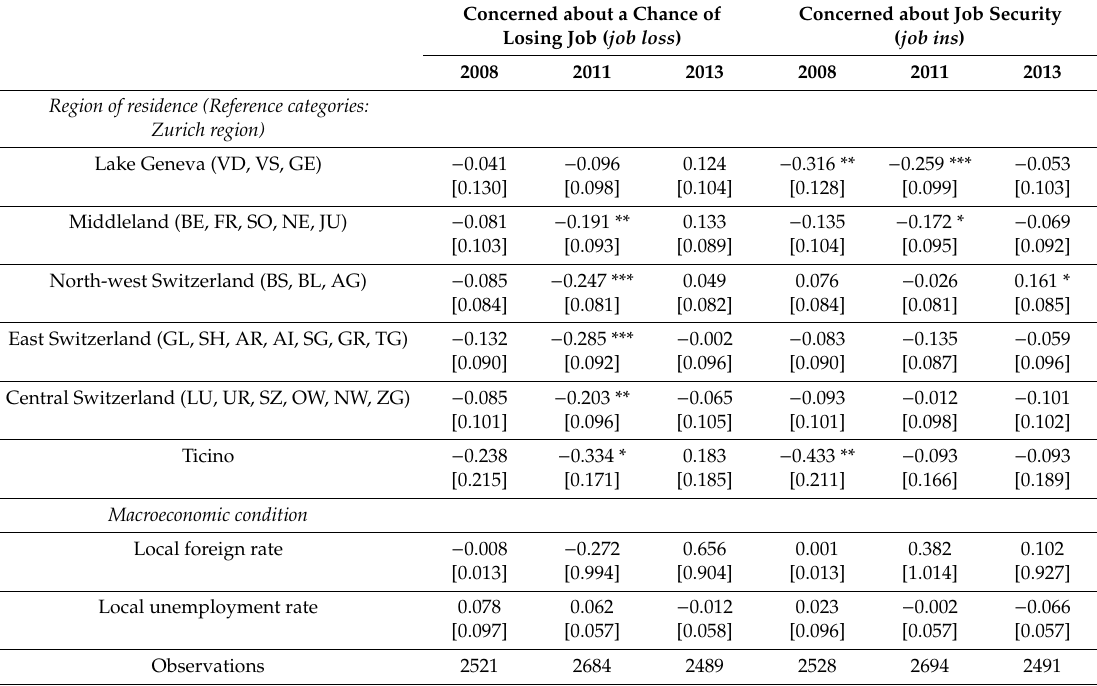
Table 2. Cont. Concerned about a Chance of Losing Job ( job loss )